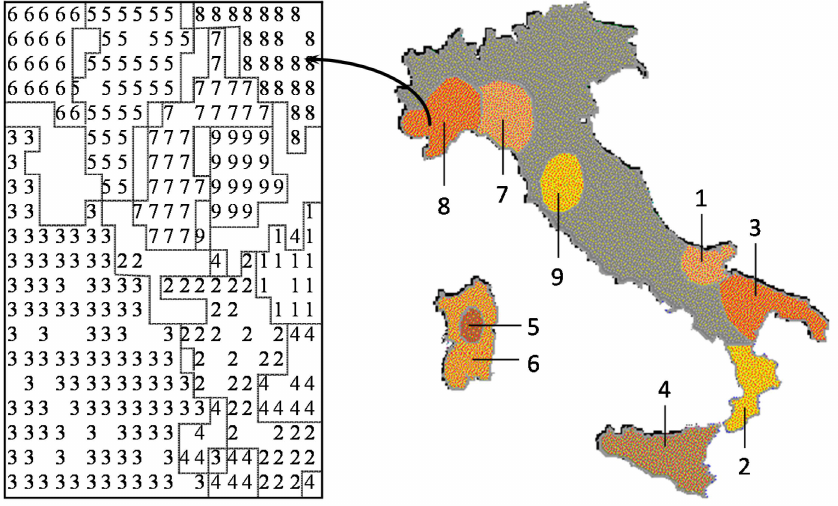
Figure 4. Comparison of the map obtained by a self-organizing neural network for olive oils from nine Italian olive growing areas with the map of